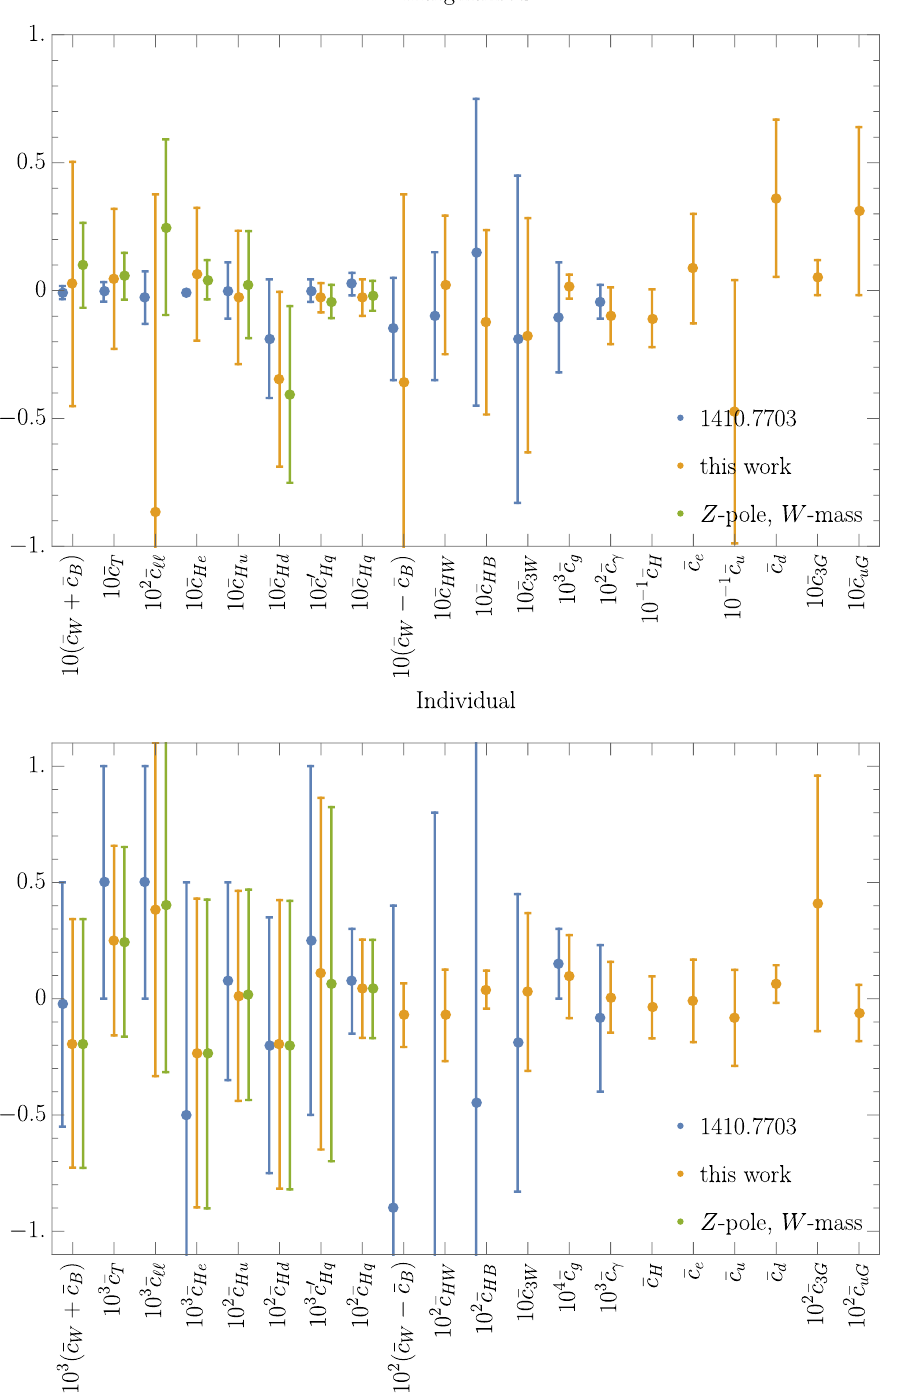
Figure 3. Results from global (cid:12)ts in the SILH basis (orange) including all operators simultaneously (upper panel) and switching each operator on individually (lower panel). Also shown are (cid:12)ts to the precision electroweak Z -pole and W -mass data (green) and results from [18] (blue). We display the best-(cid:12)t values and 95% CL ranges.